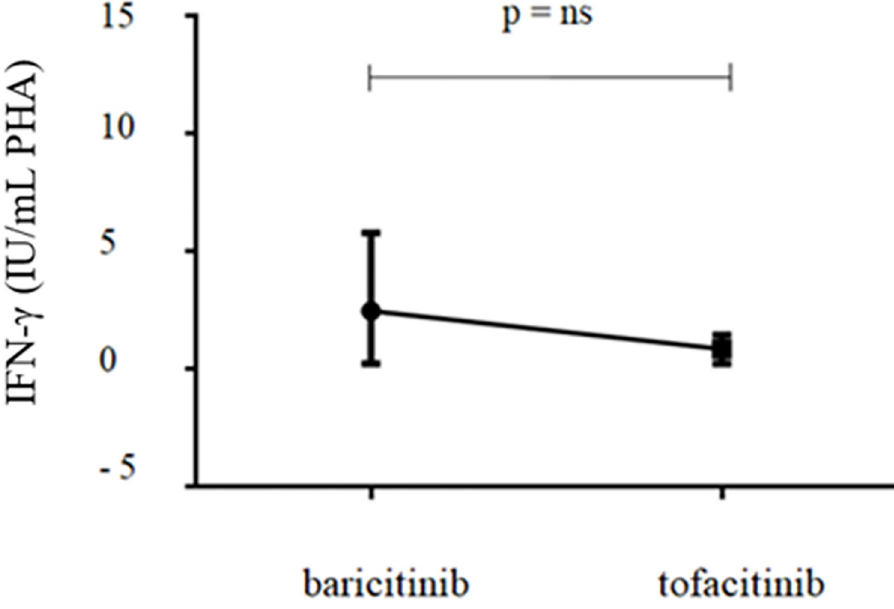
Fig 2. Median INF- γ values in response to PHA mitogen after 3 months of baricitinib and tofacitinib treatment. PHA: phytohemagglutinin.